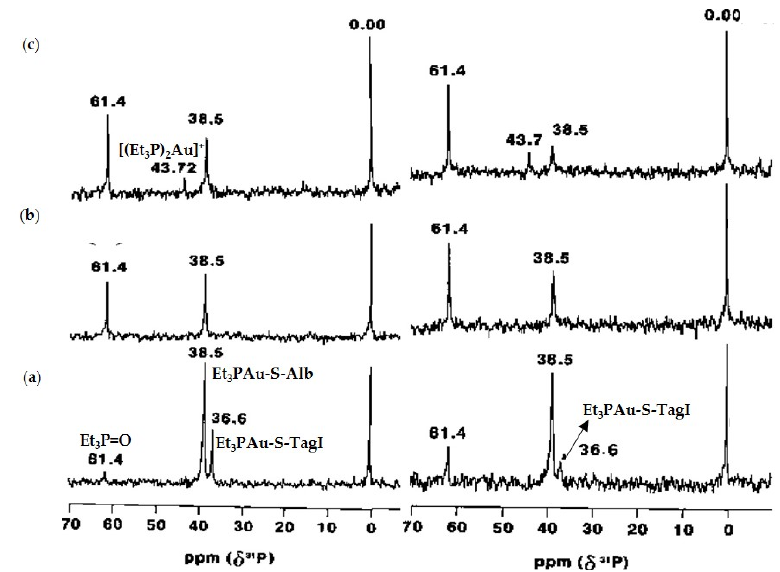
Figure 16. 31 P{ 1 H} NMR spectra of 4.3 mM BSA (containing ~50% free Cys34) incubated with Et 3 PAuX (X = S ‐ tagl, CN, Se ‐ tagl) at 1:1 ratio with the free Cys34 and measured within 1 h (left) and after 24 h (right) at pH 7.9 in deuterated NH 4 HCO 3 buffer; Et 3 PAuS ‐ tagl ( a ), Et 3 PAuCN ( b ), and Et 3 PAuSe ‐